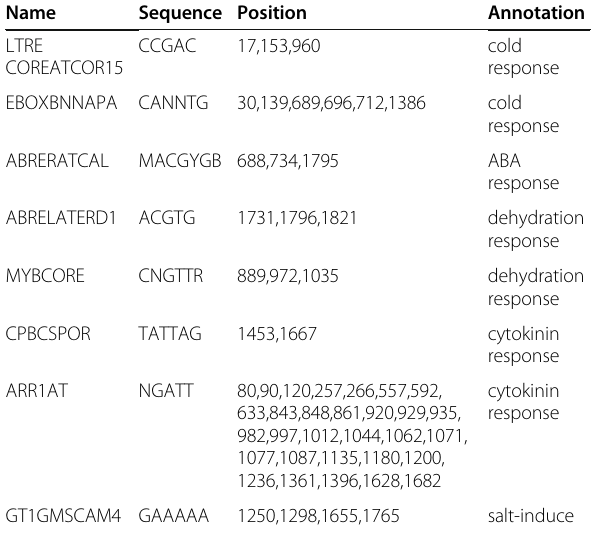
Table 1 Putative cis-acting elements in the OsGATA16 promoter